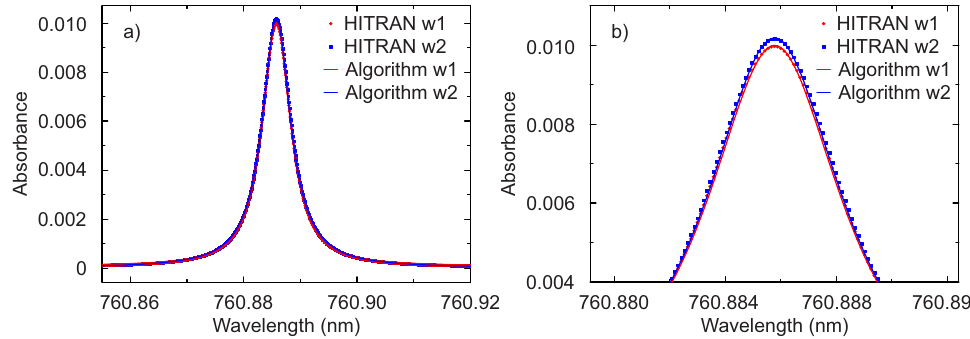
Figure 9. ( a ) comparison of the absorbance of the R7Q8 line extracted with the algorithm (solid lines; Algorithm w1, Algorithm w2) and the expected lines from HITRAN database (points; HITRAN w1, HITRAN w2) for the window 1 (w1, d = 11 mm) and window 2 (w2, d = 4 mm); ( b ) enlargement of the peak maximum for the same